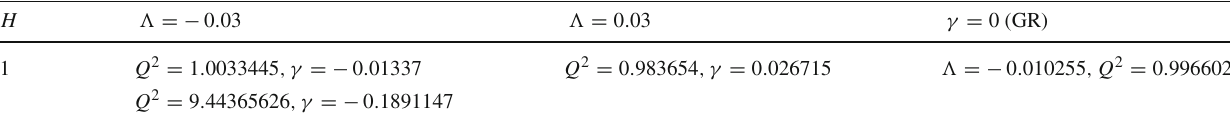
Table 4 Summary table of near-extremal BH parameters with potential CSCC violation for M = 1 , r H − r C = 10 − 2 , C 1 -SCC is always valid. BHs with (cid:6) < 0 in this Table have no cosmic horizon and are not subject to the β